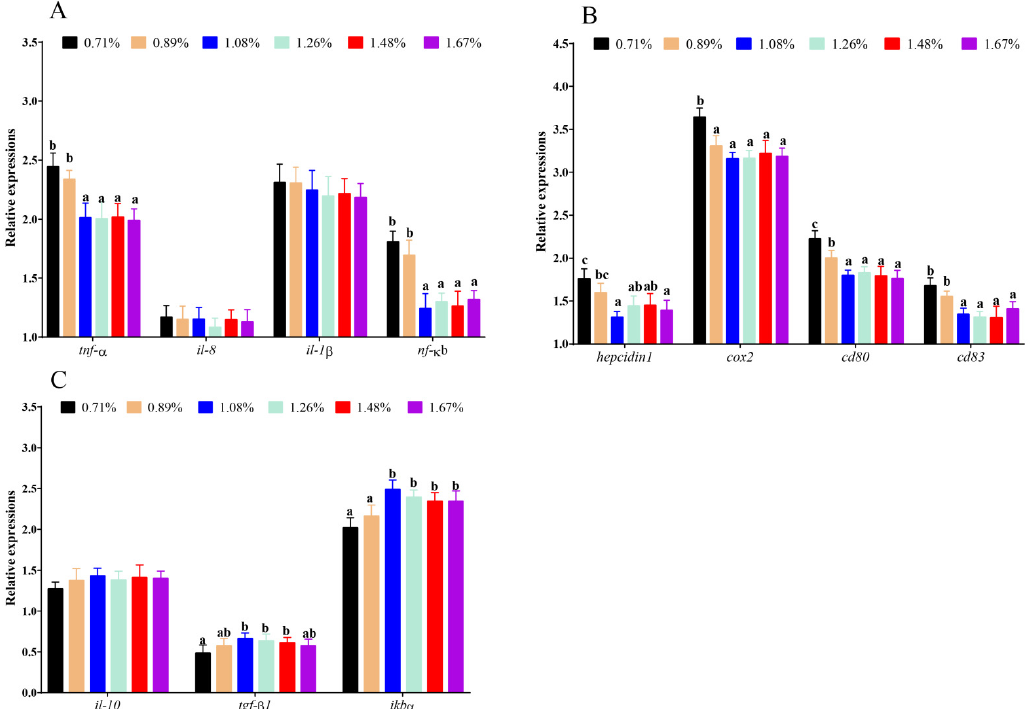
Figure 5. The mRNA levels of inflammatory-related genes against graded different levels of dietary histidine. ( A ) showed the results of tnf- α , il-8 , il-1 β and nf- κ b . ( B ) showed the results of hepcidin 1, cox2, cd80 and cd83. ( C ) showed the results of il-8 , tgf- β 1 and ikb α . Data are presented as mean ± standard deviation ( n = 3 × 3). Values with different alphabetical superscripts above bars are significantly different ( p < 0.05).